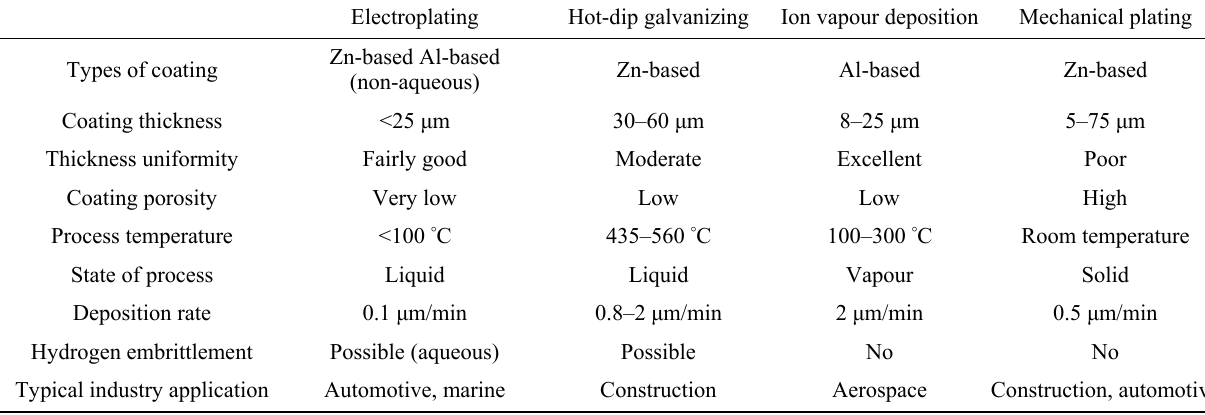
Table 7 Comparisons of fastener coating deposition